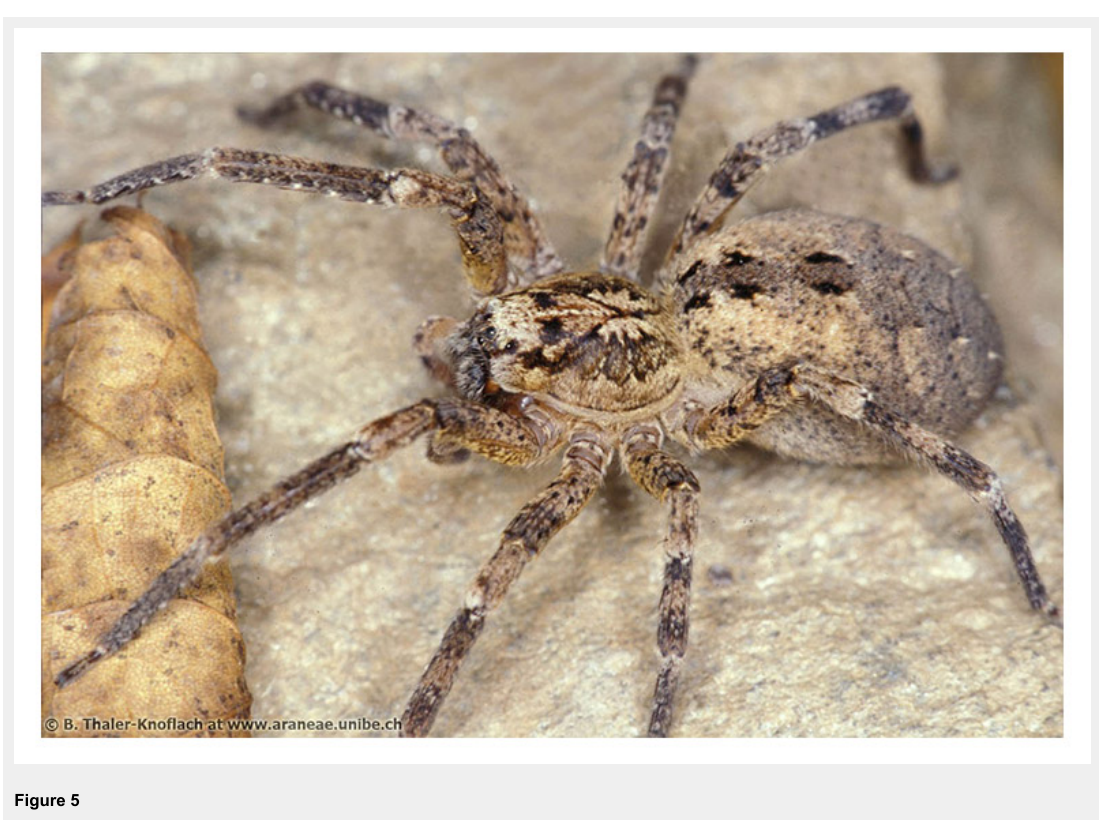
Figure 5 Zoropsis spinimana, female